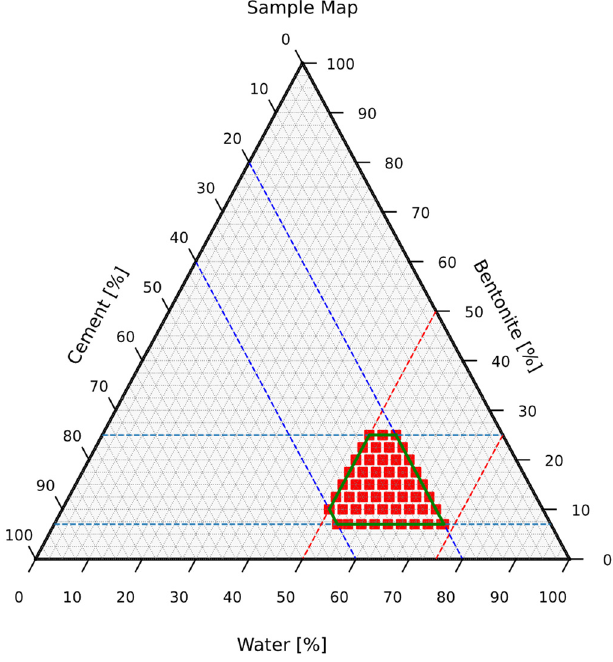
Figure 1. Mesh of cement–bentonite–water combinations. The ternary subdomain is used as a planimetric representation of mixtures for which various parameters (such as viscosity and the coefficient of permeability) are represented. To provide a proper representation, the areas outside of the represented domain were cropped (Figure 2). The limit lines were set based on the values of the